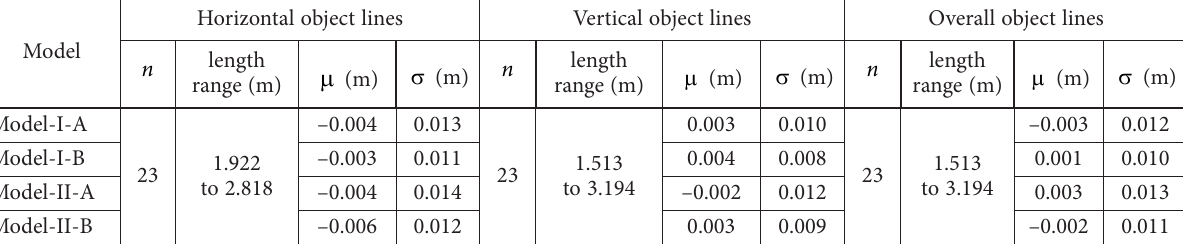
Table 6. Results for Camera-I